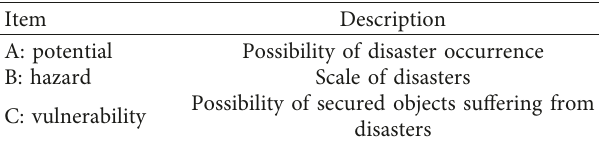
Table 1: Evaluation items for hillside disaster-resistant